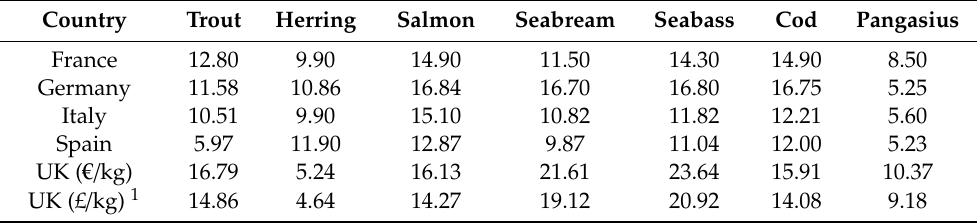
Table A1. Average price levels ( € / kg, and £ / kg for the UK) by fish species in each